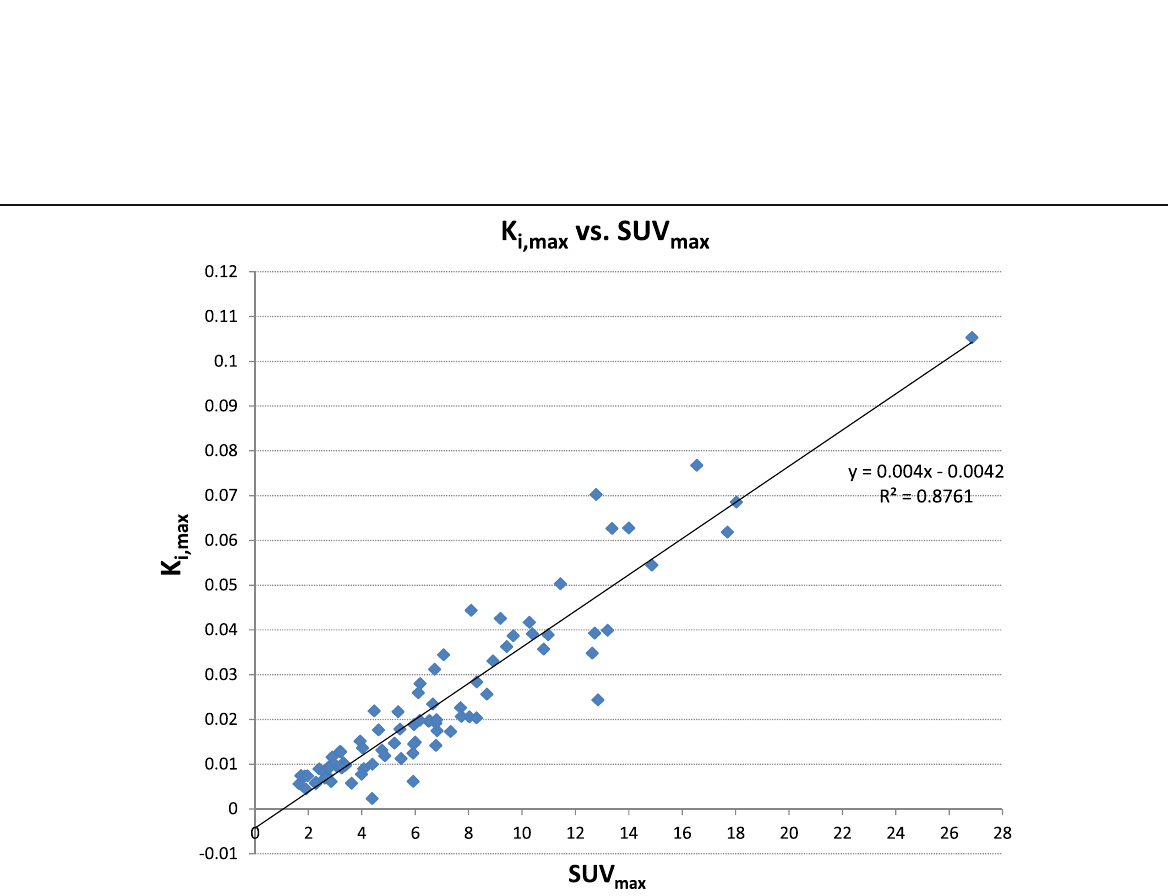
Fig. 8 Regression line between the ParaPET K i,max value and SUV max